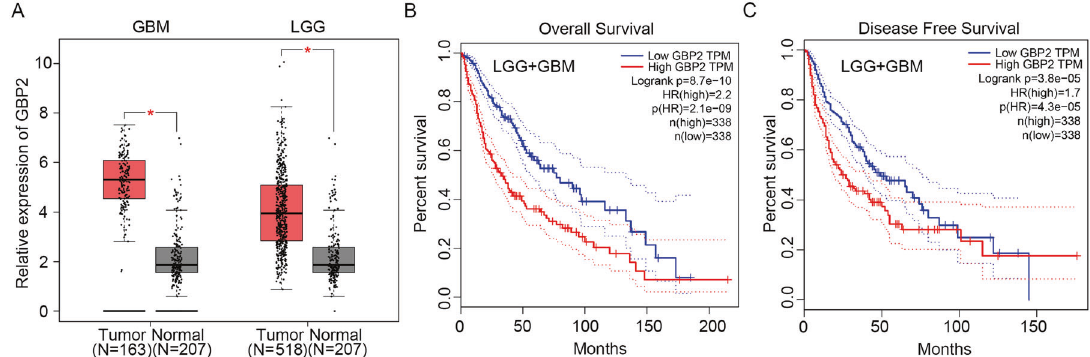
Fig. 1 GBP2 is highly expressed in glioma. A GBP2 expression is highly elevated in glioma cells. Analysis of GBP2 expression in GBM and LGG from The Cancer Genome Atlas (TCGA) database. B Overall survival in patients with different GBP2 expression levels. C Disease-free survival in patients with different GBP2 expression levels.